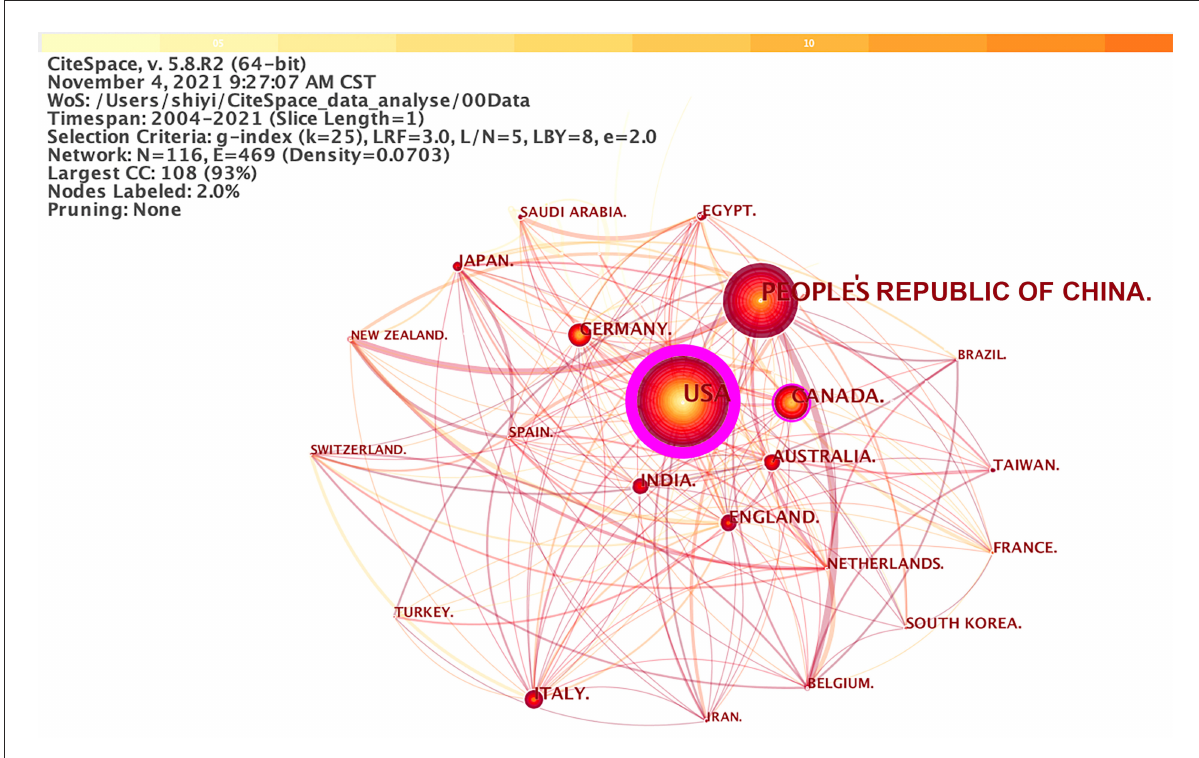
FIGURE4 The cooperation network of productive